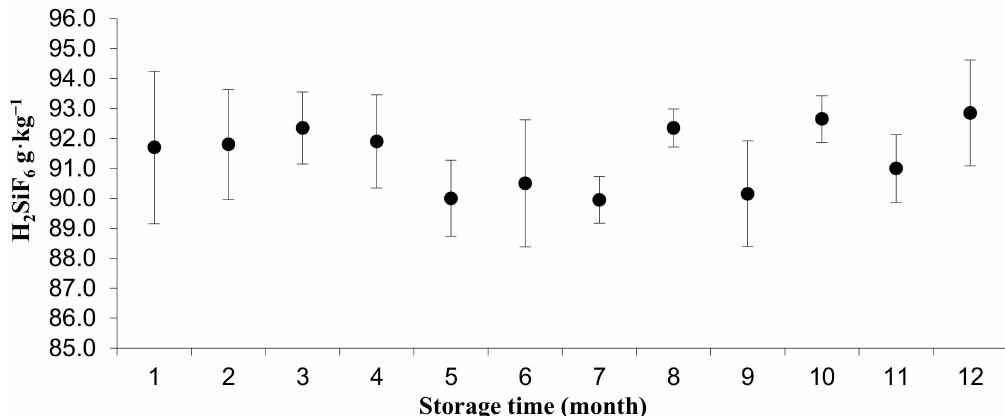
Figure 3. H 2 SiF 6 mass fraction during the long-term stability test. Points and bars show the mean values and standard deviations,